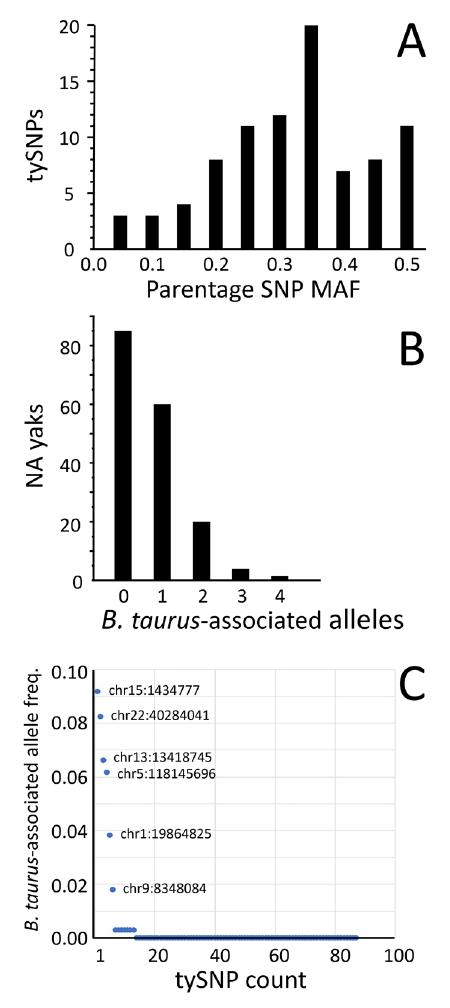
Figure 5. Allele frequency distributions of 87 tySNPs based on genotypes from 170 NA yaks. ( A ) Yak parentage SNPs MAFs. ( B ) B. taurus -associated alleles within animals. Panel C , variation in B. taurus -associated allele frequencies among different tySNPs. (Figure5_87_SNPs_MAFCatt4.TIF)